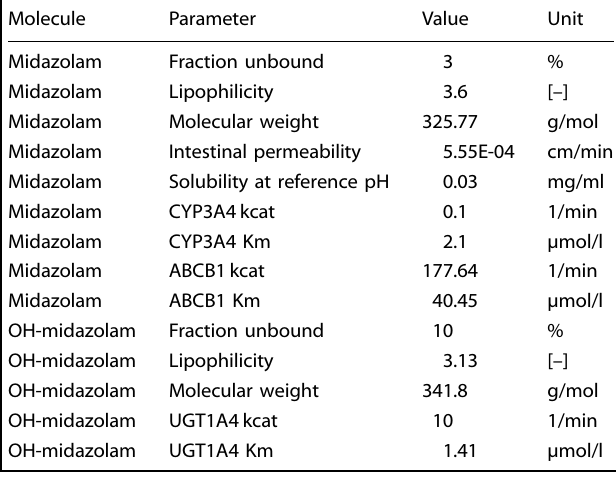
Table 3. Parameterization of the midazolam mean value model